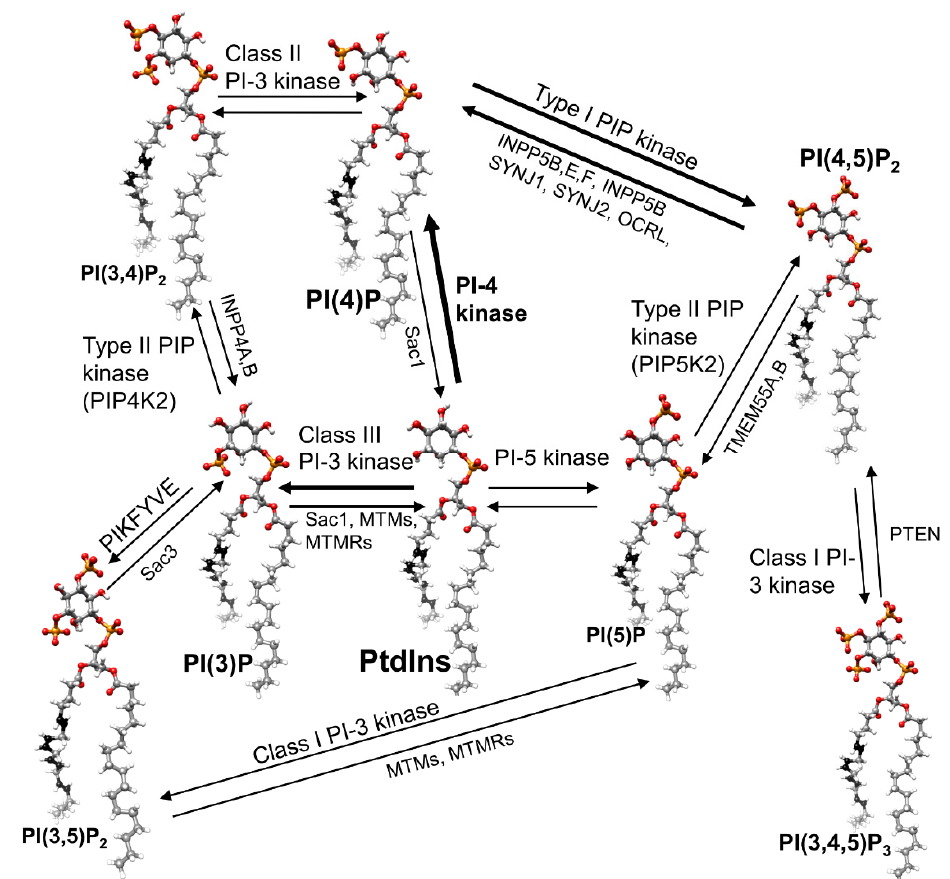
Figure 1. Structures of the cellular phosphoinositides and enzymes responsible for their synthesis and interconversion. Phosphoinositides (PI) species are shown with the acyl chains most commonly found on phosphatidylinositol, which is the starting point for all the others, arachidonic acid (20:4) and stearic acid (C18). Relative font sizes correlate with relative abundance.